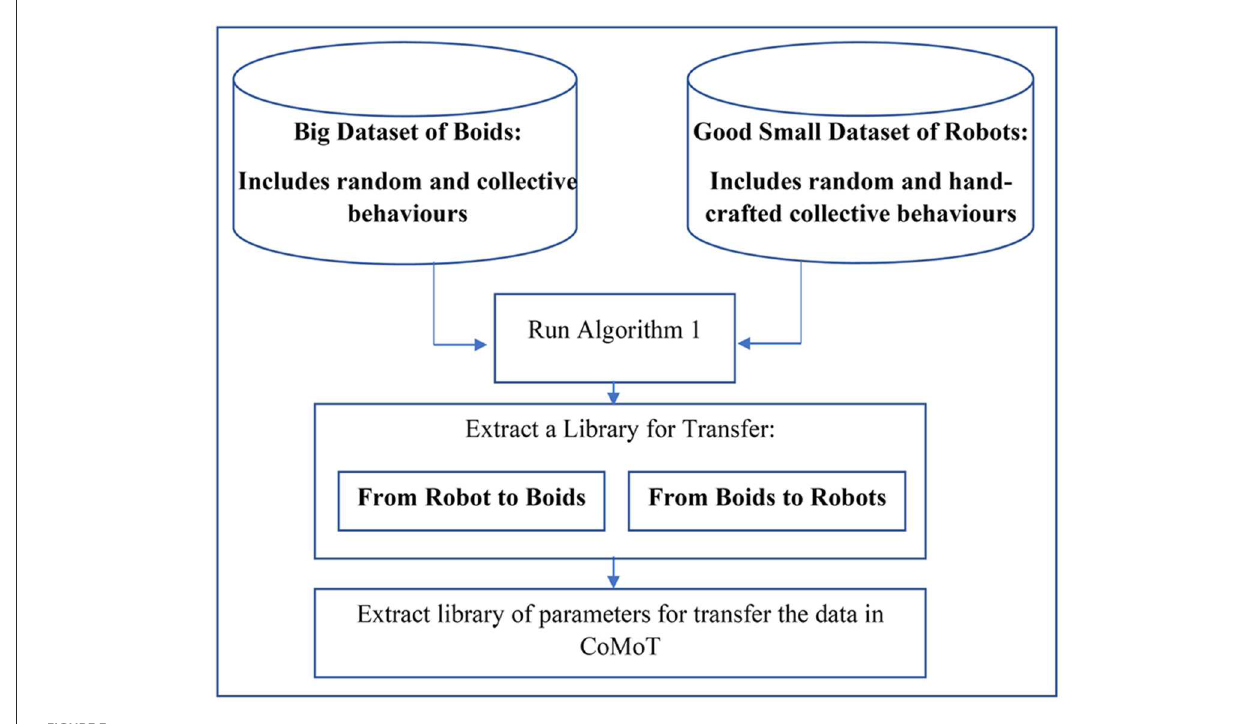
FIGURE3 One shot transfer learning to extract a library for